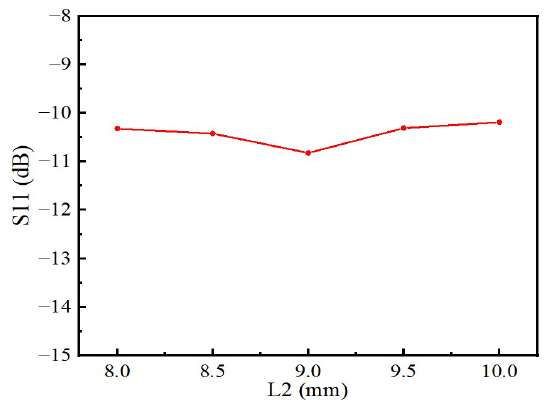
Figure 6. Influence of L2 on the reflection coefficient. Table 1. Dimensions of the